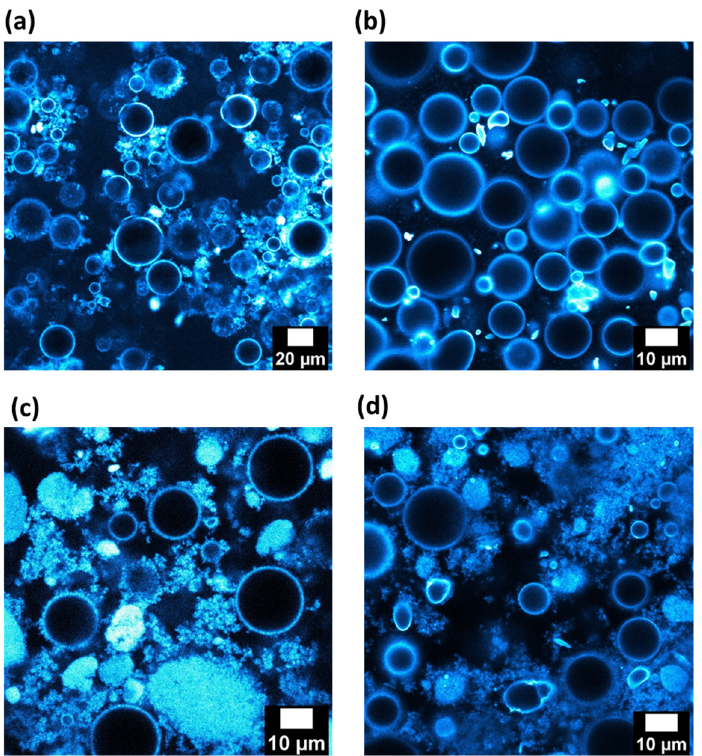
Figure 5. Confocal fluorescence images of ( a ,c) reverse Water/Dodecane and ( b , d ) direct Dodecane/Water emulsions prepared with (a,b) 1 wt.% and ( c , d ) 4 wt.% of silica particles.